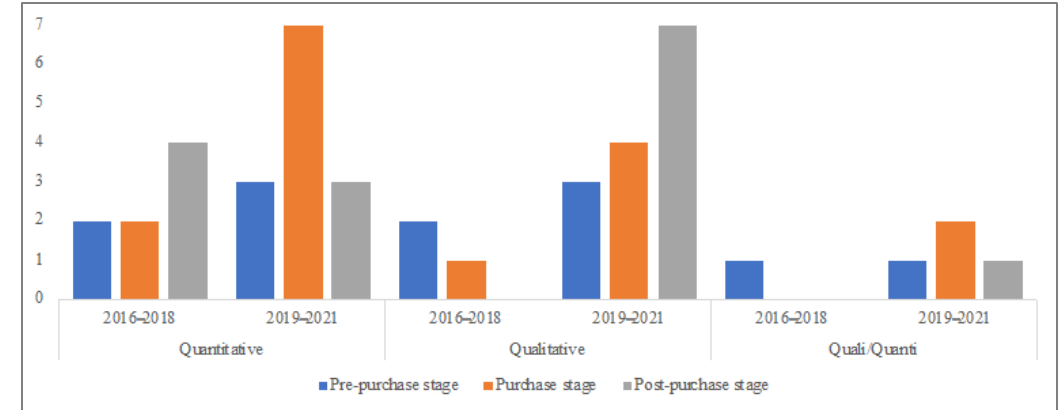
Figure 5. Classification of research approaches.